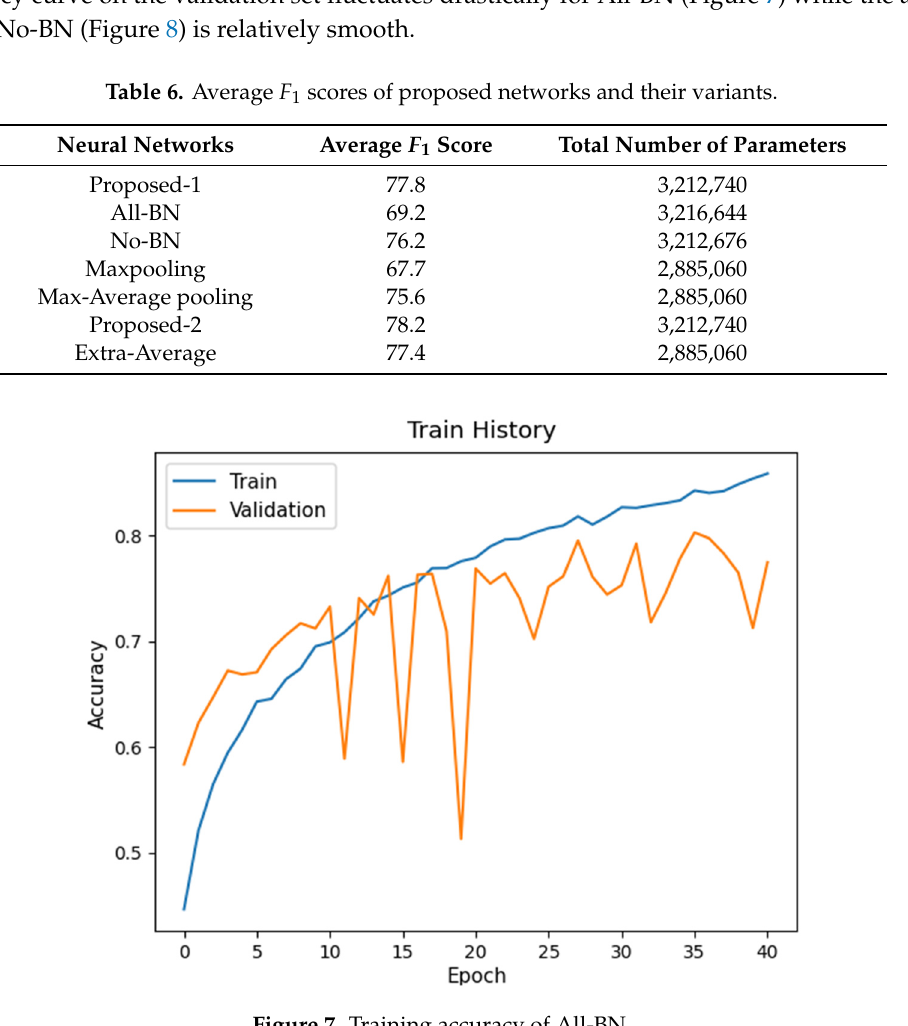
Figure 8. Training accuracy of No-BN. A vanilla CNN usually combines the convolutional layer and Maxpooling layer as a block and repeats this before the flatten layer [36]. We investigated how the Maxpooling layer placed before the flatten layer affects accuracy. The result shown as “Maxpooling” in Table 6 reflects that the accuracy degrades significantly, and this variant yields the worst accuracy. The reason can be traced back to the characteristics of Maxpooling. In Maxpooling operation, it only keeps the maximum element and removes the others. This method may not preserve the originality of the data and is likely to eliminate the distinguishing features in the same pooling region [38]. In order to investigate the effect of pooling methods, we replace Maxpooling in Proposed-1 with average pooling, and the result is shown as Proposed-2 in Table 6. It is obvious that Proposed-2 outperforms Proposed-1 and its variants. This may be due to the effect that average pooling keeps